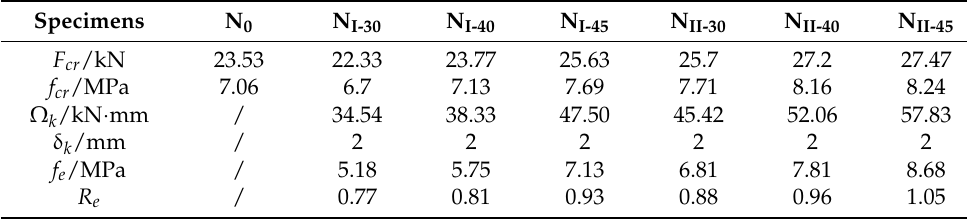
Table 8. Calculation results of the mechanical properties of SFRC after fire.